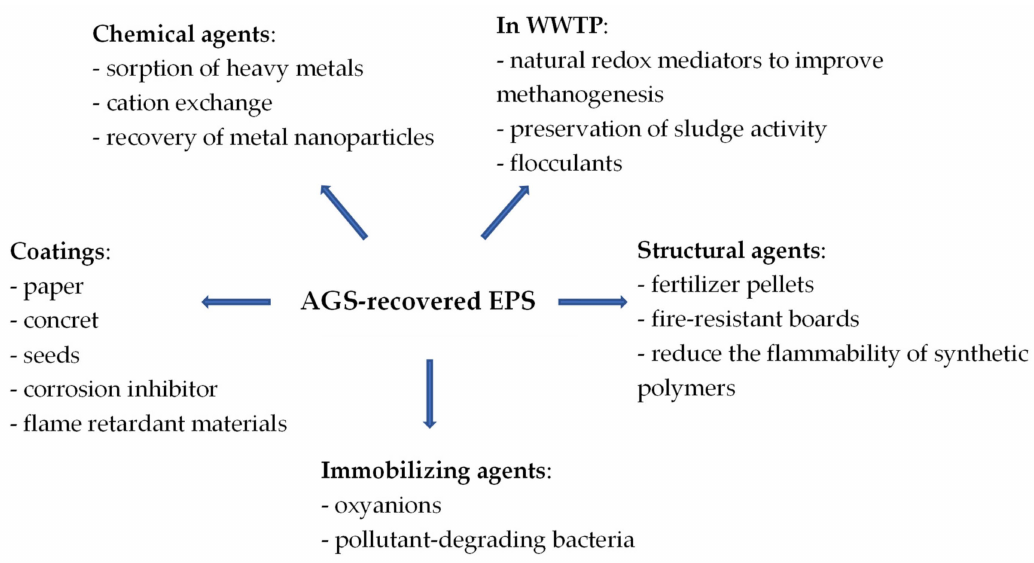
Figure 2. Possibility of reusing polymers extracted from waste sludge from a